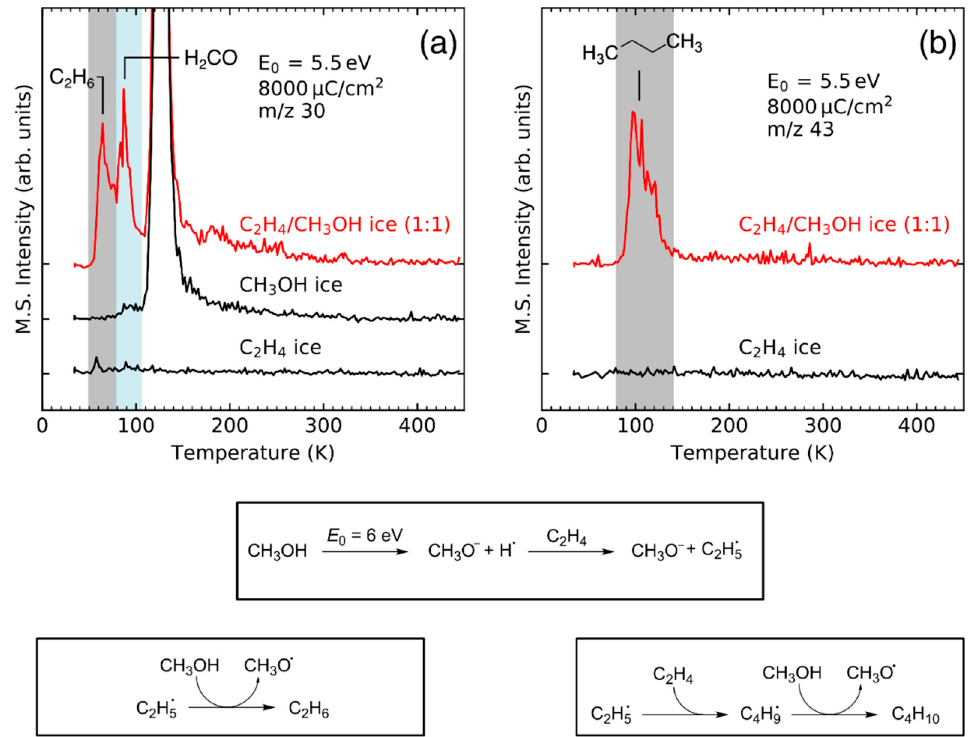
Figure 13. Thermal desorption spectra obtained after irradiation of C 2 H 4 /CH 3 OH (1:1) mixed ices and of pure C 2 H 4 and pure CH 3 OH at 5.5 eV with 8000 µ C/cm 2 . The desorption signal at 60 K in the m / z 30 curve (shaded in grey, panel ( a )) was assigned to ethane (C 2 H 6 ) whereas the signal at 100 K in the m / z 43 curve (shaded in grey, panel ( b )) was assigned to butane (C 4 H 10 ). Notably, no significant amounts of ethane and butane are formed in pure C 2 H 4 and CH 3 OH. Furthermore, the intensity of the desorption signal of H 2 CO (shaded in blue, panel a) in irradiated C 2 H 4 /CH 3 OH mixed ices is significantly higher than in pure CH 3 OH. The reaction scheme (bottom) denotes the formation of ethane and butane following DEA to CH 3 OH yielding CH 3 O − and H • . Adapted with permission from Ref. [32]. Copyright 2019 American Chemical